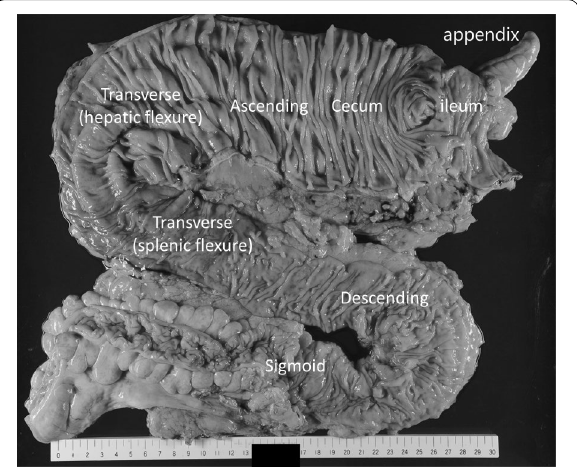
Fig. 5 Macroscopic findings. Dilated colon from the cecum to the transverse colon and an abrupt change in diameter in the transverse colon, near the splenic flexure. No abnormal findings detected in the